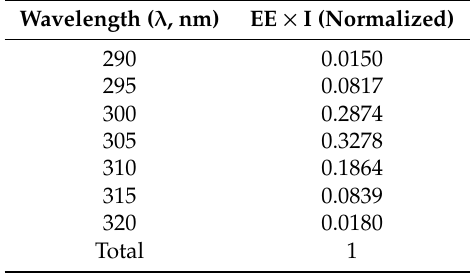
Table 6. Normalized product function used in the calculation of SPF. EE—erythremal e ff ect spectrum, I—solar intensity spectrum; values adapted from the work of Sayre and co-workers